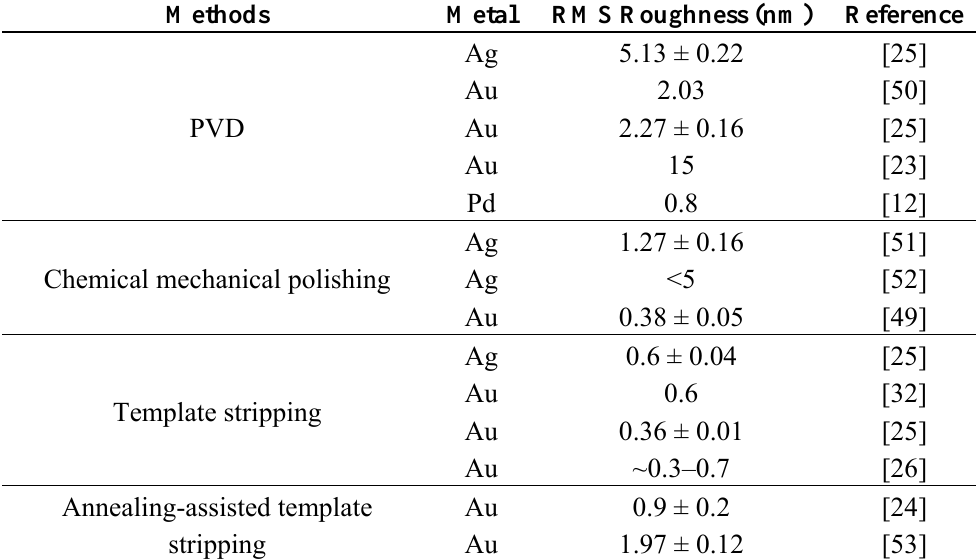
Table 1. Summary of substrates root mean square (RMS) roughness fabricated by different prepared